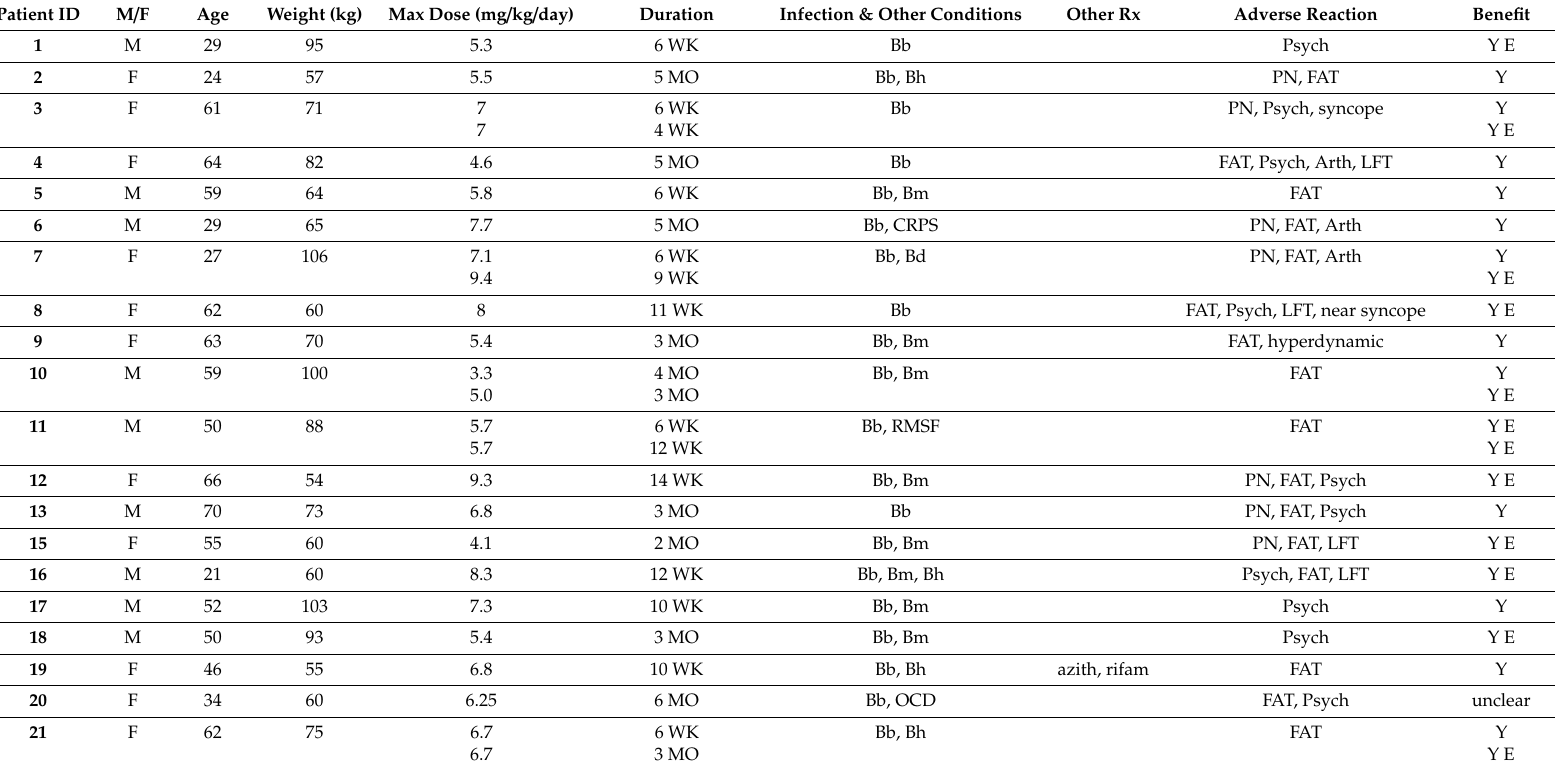
Table 1. Summary of patients on high dose ( ≥ 4 mg / kg / day) disulfiram ( n =